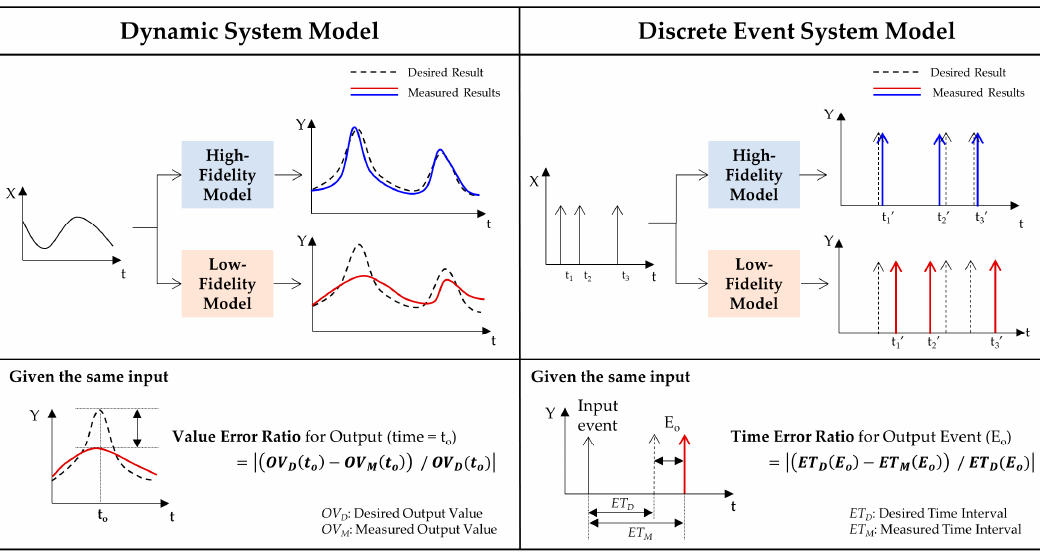
Figure 3. Output errors of high- and low-fidelity models: Value error for the dynamic system model and time error for the discrete event system model.